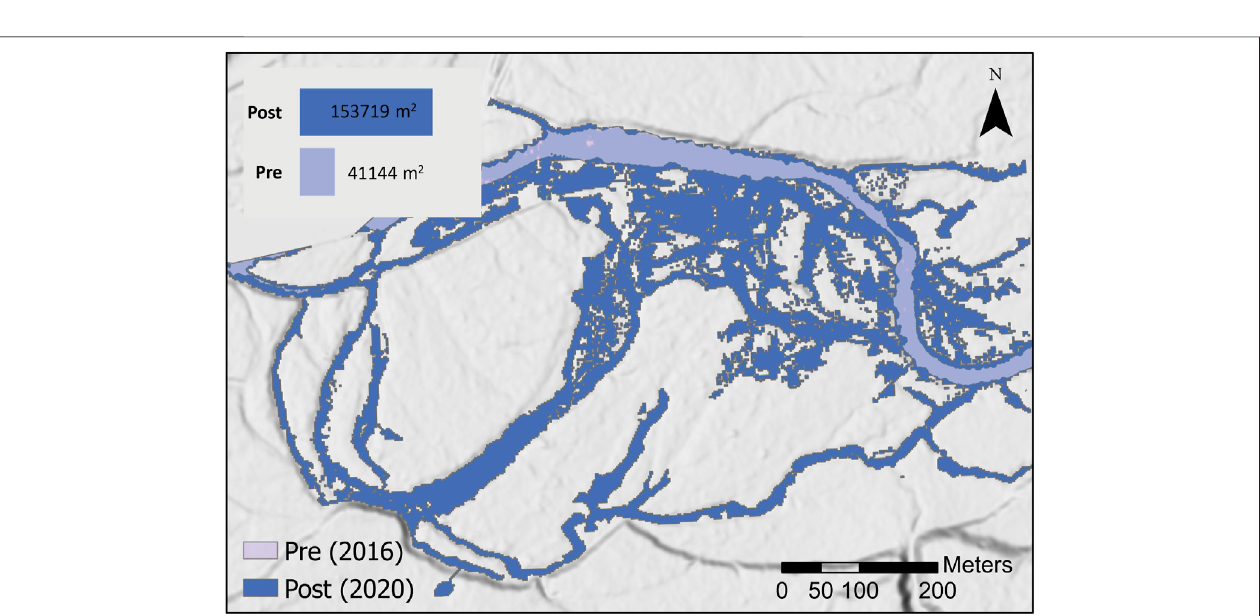
FIGURE 11 | Wood (colored in yellow) on the valley fl oor of the Deer Creek, Oregon site: (A) shortly after restoration was completed; (B) 1 year post-restoration; (c,d) insets showing placement of wood latices; and (e,f) insets of parallel locations showing accumulation of wood material after overbank fl ow events of the winter